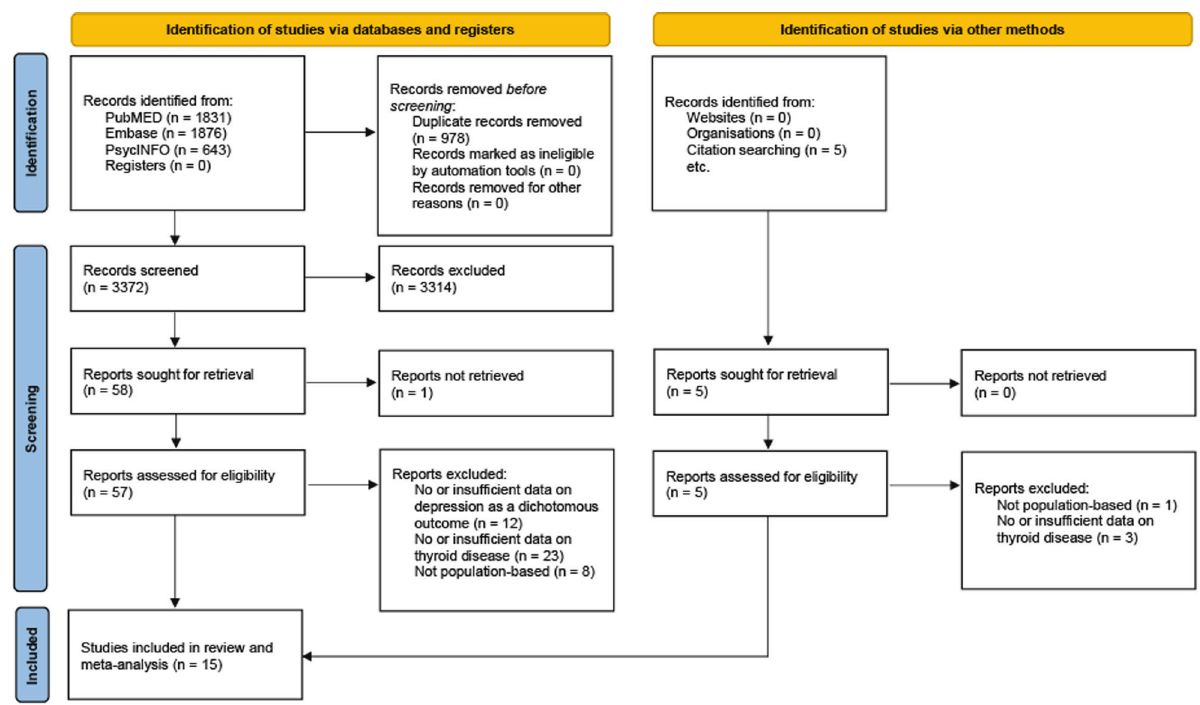
Fig. 1 PRISMA fl ow diagram showing the study selection process.